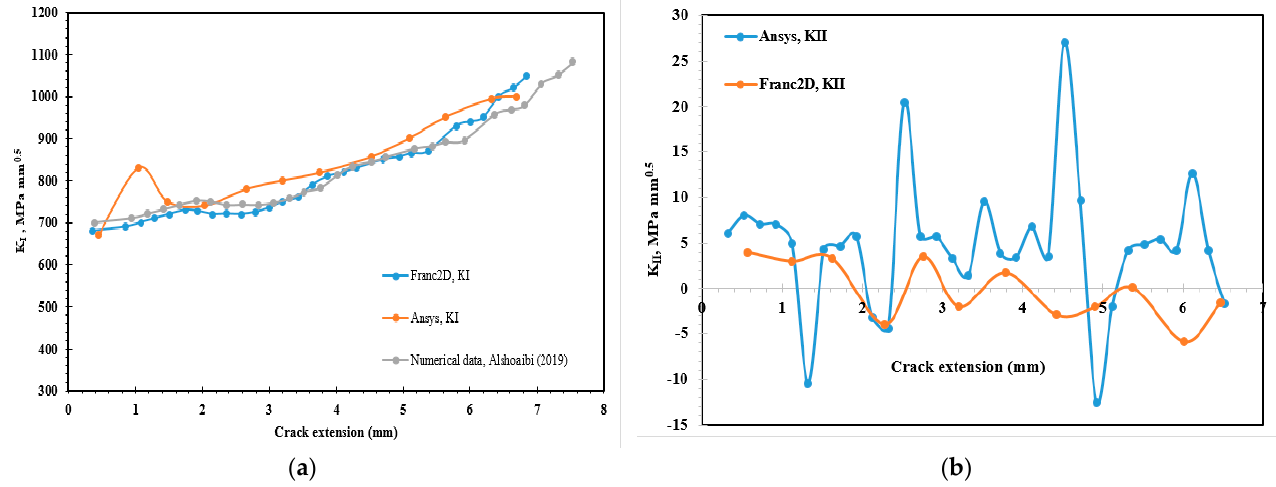
Figure 7. Stress intensity factors with corresponding crack length for specimen G2, ( a ) K I and ( b ) K II .